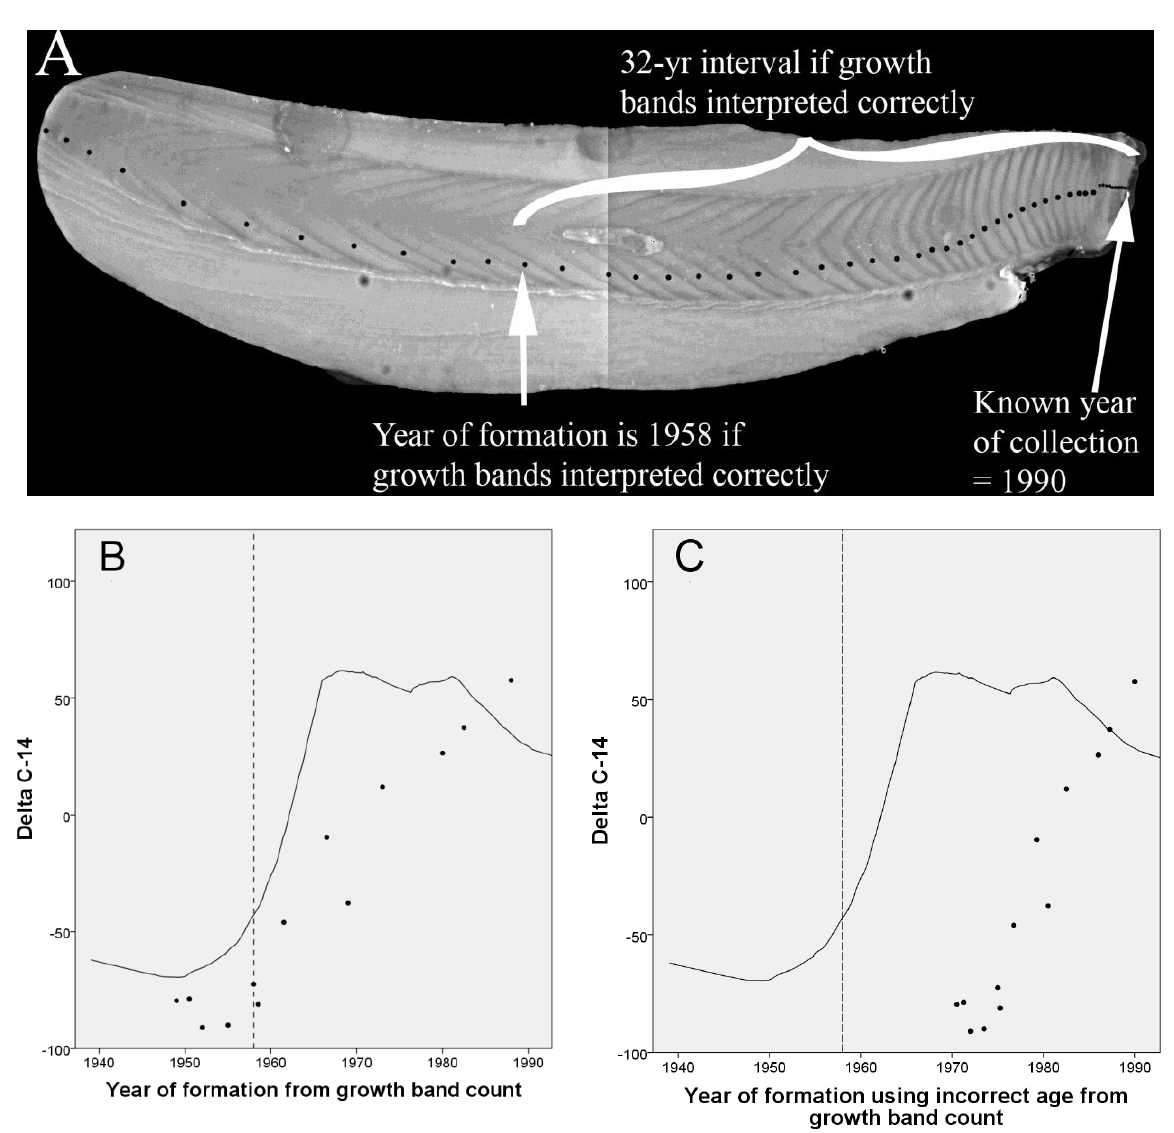
Fig. 2. (A) Longitudinal section of a beluga tooth showing presumed annual growth bands. Dates of formation can be determined by counting the growth bands in from the growing edge (right or pulp edge in this image), which corresponds to the year of collection. (B) Bomb radiocarbon assays of individual growth bands in the tooth shown begin to increase around 1958 (vertical dashed line) in synchrony with the marine reference chronology (solid line) if the growth bands have been aged and counted correctly (i.e. one GLG per year), but (C) are greatly offset from the marine reference chronology if the growth bands have been interpreted as forming twice per year (2 GLG per year). Years shown in this example are